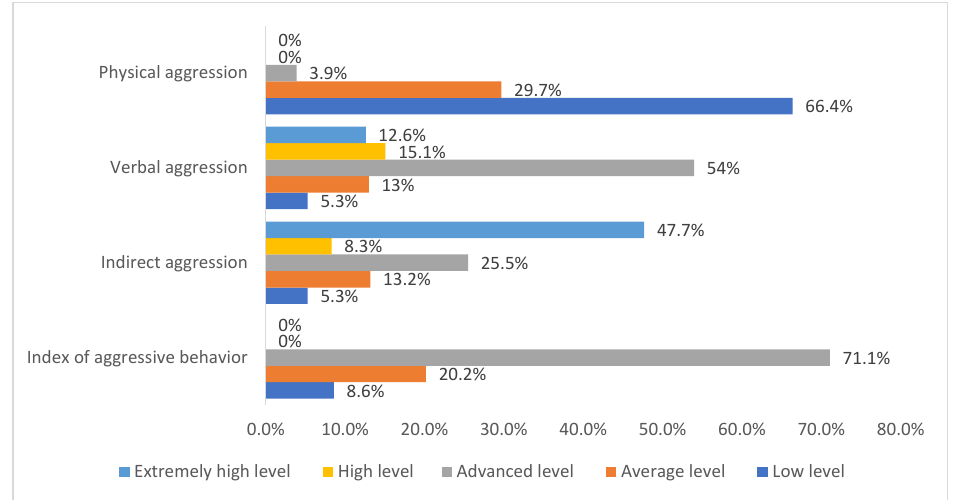
Figure 8. The frequency distribution of COVID-19 ICU physicians by the levels of the components of aggression.